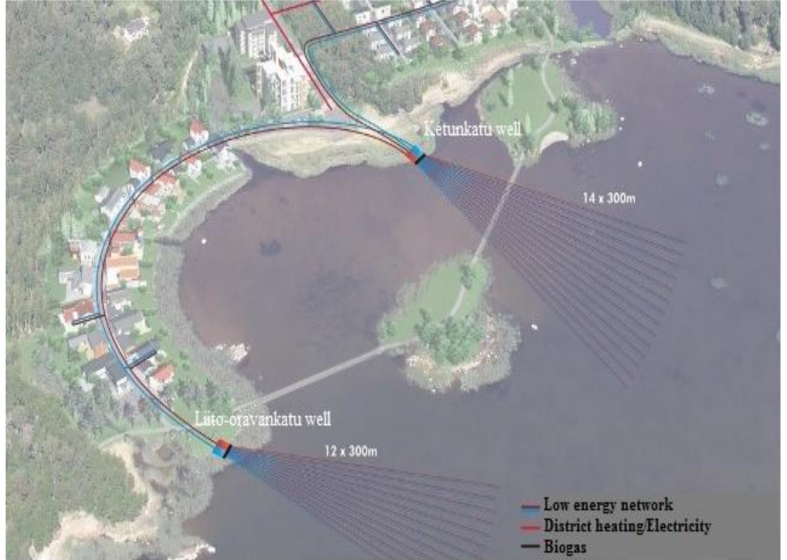
Figure 1. Suvilahti low-energy network sharing heating and cooling for 42 houses (Vaasan Ekolämpö